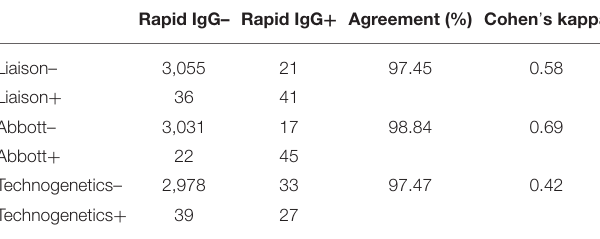
TABLE 2 | Comparison of rapid IgG assay and anti-S IgG Abbott and DiaSorin assays. Rapid IgG– Rapid IgG + Agreement (%) Cohen ’ s kappa